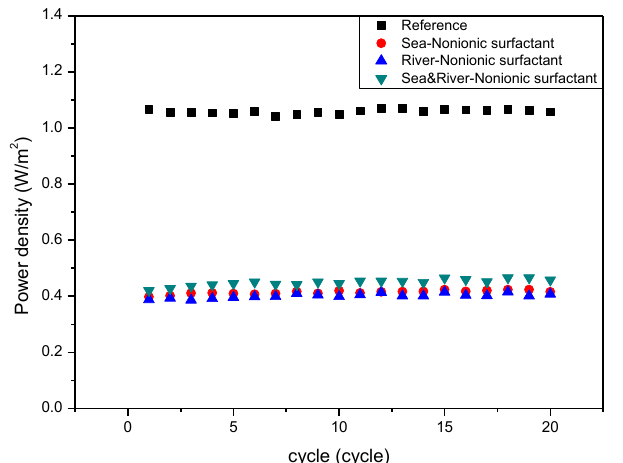
Figure 7. Variation of power density of the RED systems with the number of operation cycles with respect to the presence of the non-charged foulant (PEG 400) included in seawater, river, or both.